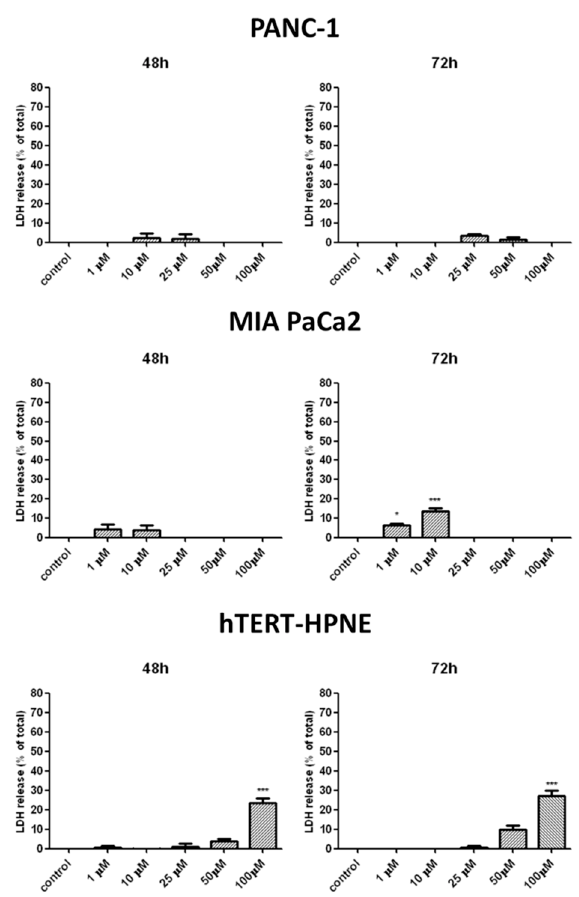
Figure 4. LDH release from PANC-1, MIA PaCa2 and hTERT-HPNE cells after 48 h and 72 h of incubation in the presence of the T1 complex. Data are mean ± SD of 3 separate determinations. * p < 0.05; *** p < 0.001, as compared with untreated cells.